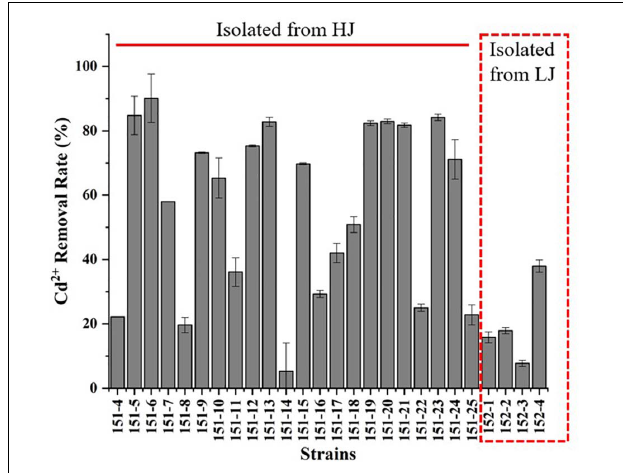
FIGURE 5 | Evaluation of Cd 2 + removal rate for Cd-resistant Bacillus sp. bacteria, which was measured in LB liquid medium supplementation with 0.1 mM CdCl 2 and shaken at 200 rpm at 37 ◦ C for 24